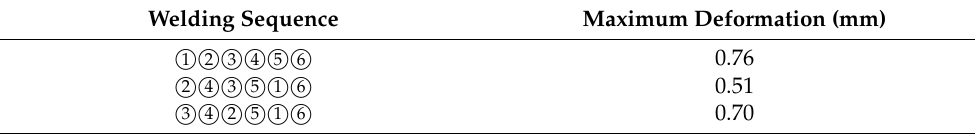
Table 3. Welding deformation under different welding